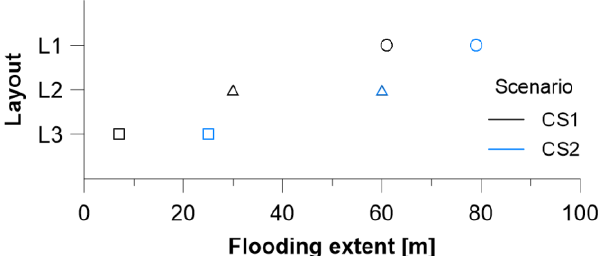
Figure 10. Flooding extent for the combinations of layouts L1 , L2 , L3 and scenarios CS1 and CS2 . Flooding extent is measured from the shoreline at SWL (horizontal distance).